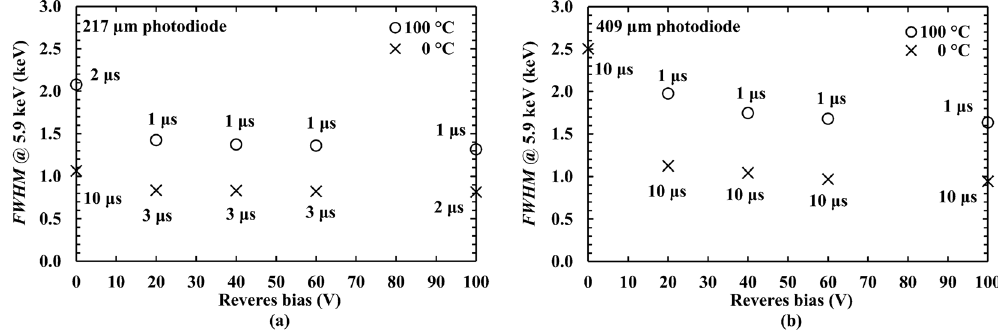
Figure 3. Measured best energy resolution ( FWHM at 5.9 keV) achieved using ( a ) the 217 µ m diameter photodiode and ( b ) the 409 µ m diameter photodiode as functions of applied reverse bias at each investigated temperature and at the optimum shaping time, 100 °C (open circles), and 0 °C ( × symbols).